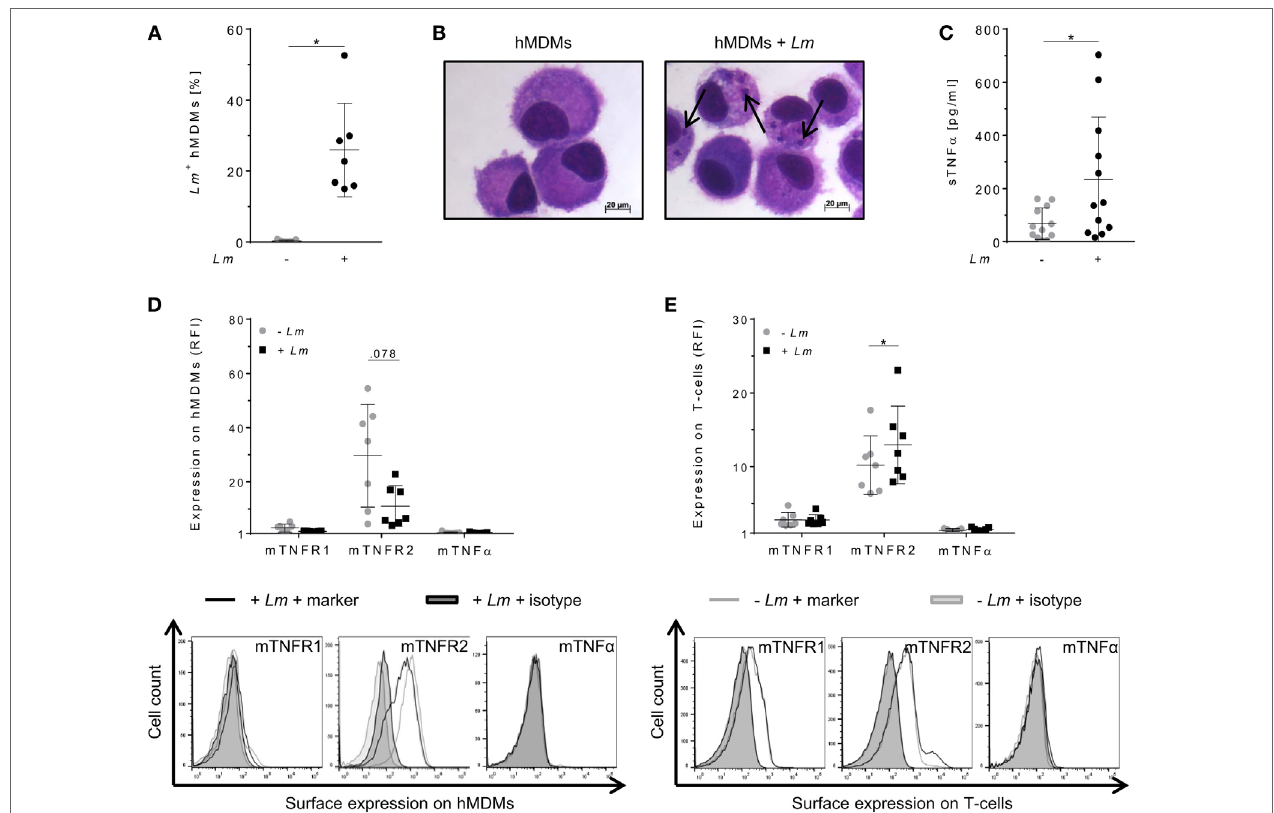
FigUre 1 | Expression of tumor necrosis factor α (TNF α ) and mTNFRs by human monocyte-derived macrophages (hMDMs) or T-cells after Leishmania major ( Lm ) infection. Macrophages were infected with fluorescent Lm (multiplicity of infection = 20) and analyzed after 24 h. (a) Infection rates in hMDMs were determined by flow cytometry in comparison to non-infected hMDMs. (B) Infected and non-infected hMDMs were stained with Diff-Quik ® and representative micrographs are depicted. Black arrows indicate Lm parasites. (c) The concentration of soluble TNF α (sTNF α ) in supernatants of hMDMs in the presence or absence of Lm was measured by ELISA 24 h post-infection. (D) Cell surface expression of mTNFR1, mTNFR2, or mTNF α on hMDMs was analyzed by flow cytometry 24 h after infection. (e) Peripheral blood lymphocytes were co-incubated with infected/non-infected hMDMs and cells were measured by flow cytometry after 7 days, with T-cells being defined by anti-CD3 Ab co-staining. (D,e) Relative fluorescence intensity was measured as the ratio of the mean fluorescence intensity (MFI) of specific markers to the MFI of isotype controls. Histograms show expression on hMDMs or T-cells in the non-infected (gray line) or infected culture (black line) in comparison to the isotype controls (black/gray solid). Data are presented as mean ± SD ( n ≥ 7) and were obtained from at least two independent experiments. The Wilcoxon signed-rank test was performed to evaluate statistical significance. * P <